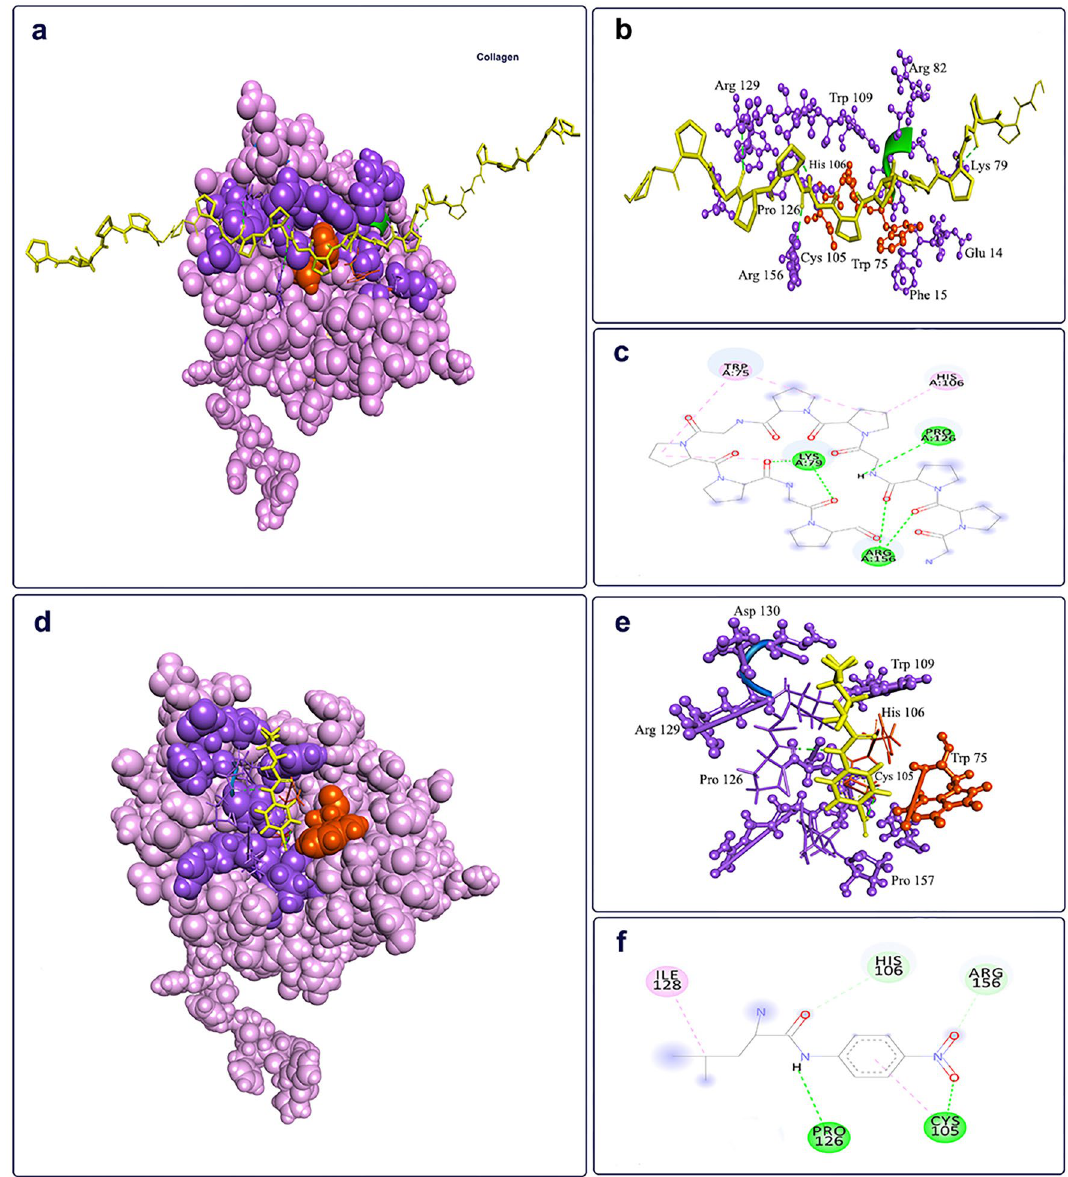
Figure 7. The active site and substrate docking of rEla. The active site residues are shown in purple and catalytic residues are shown in orange. The yellow color shows the substrates. ( a ) Docked pose for rEla in complexed with Collagen, ( b ) Active site pocket of rEla with collagen as the substrate, ( c ) 2D interactions of rEla binding site with collagen. Collagen interacts with rEla through 4 hydrogen bonds with Lys 79, Pro 126 and Arg 155. Hydrogen bonds are shown in green and hydrophobic interactions are pink. ( d ) Docked pose of rEla in complexed with l.leucine.p.nitroaniline, ( e ) Active site amino acid residues from docking